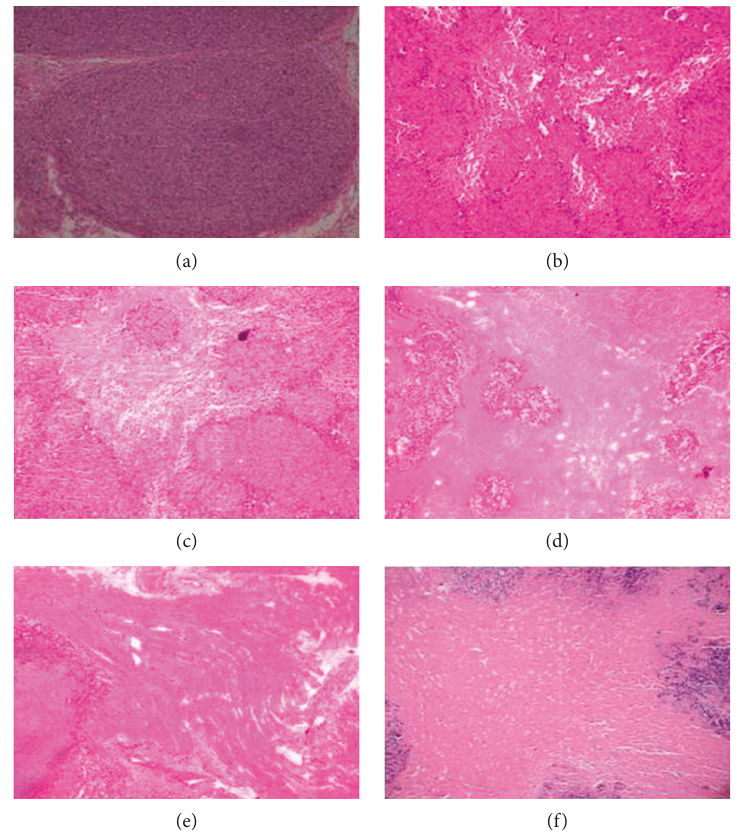
Figure 2: Histology of the subcutaneous pancreatic cancer cell mouse xenograft model after ethanol injection. On day 7, all mice were sacri fi ced and the tumor xenografts were resected for tissue processing and H&E staining. (a) 0%, (b) 20%, (c) 40%, (d) 60%, (e) 80%, and (f) 95%. The original magni fi cation was 100x.